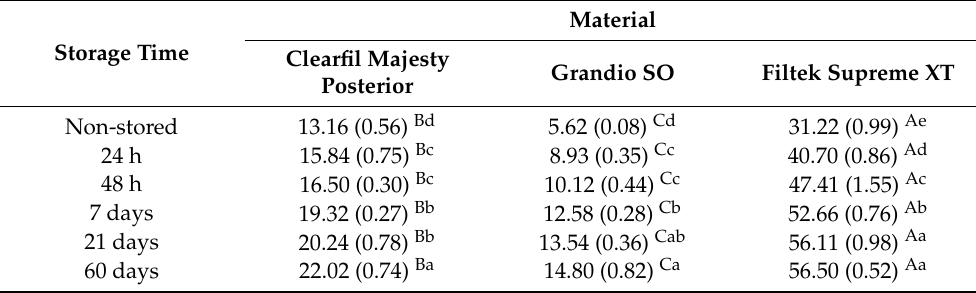
Table 3. Means (standard deviation) of water content measured in µ g/mm 3 according to material and storage time ( n =